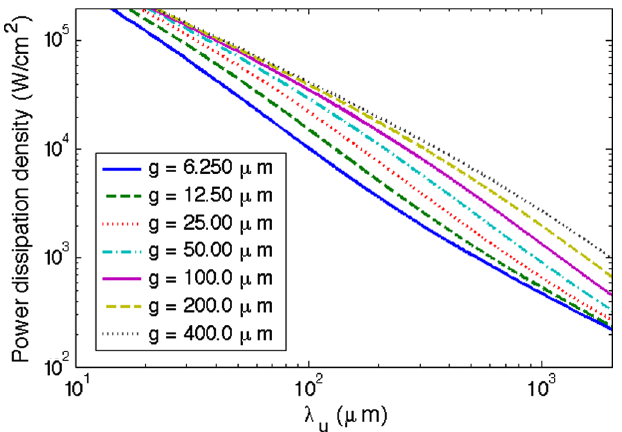
FIG. 15. Plot showing the scaling of the surface power dissipa- tion density generated by the undulator windings at saturation.